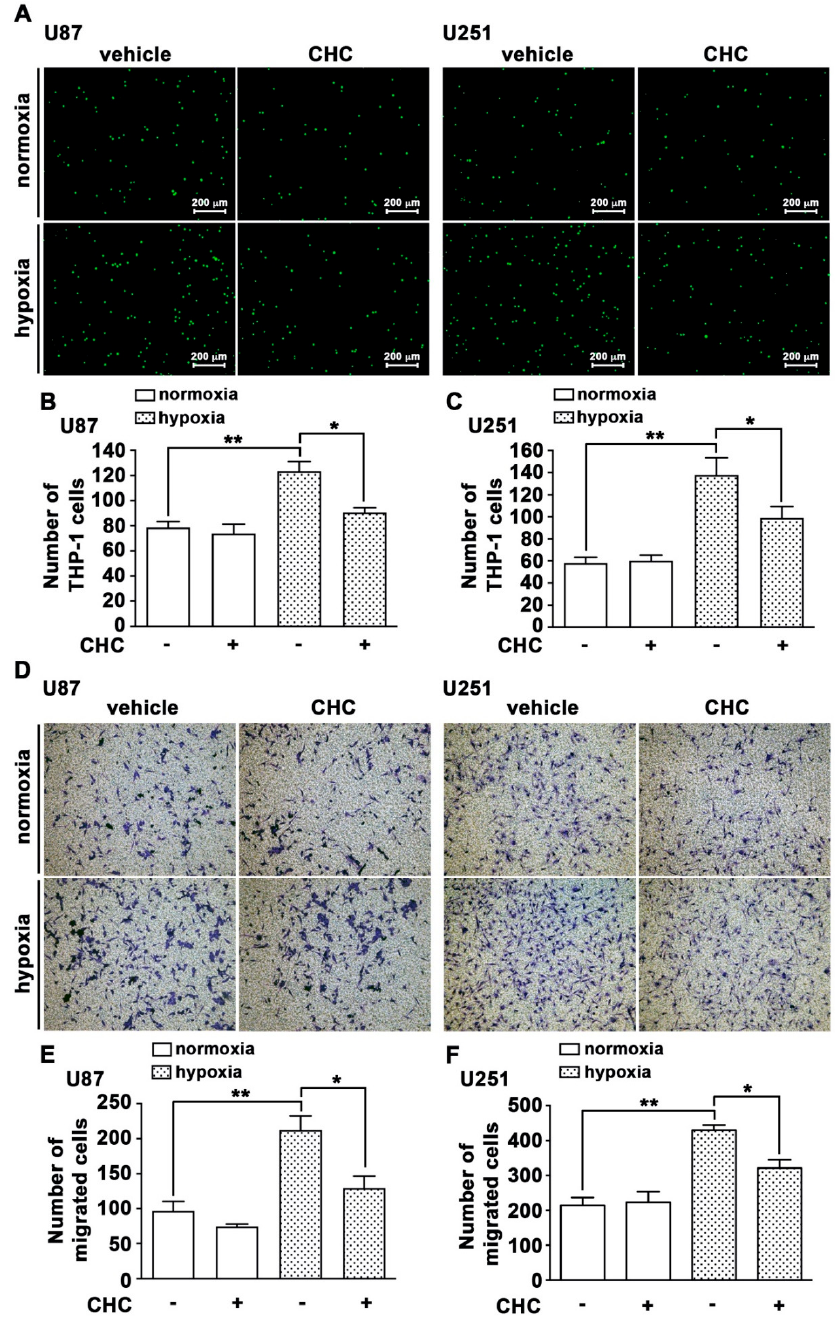
Figure 2. MCT4 is involved in hypoxia-enhanced monocyte adhesion and GBM migration. ( A ) U87 and U251 were treated with an MCT4 inhibitor (CHC; 1 or 2.5 mM) for 30 min and were exposed to hypoxic conditions (1% O 2 ) for 24 h. BCECF-AM-labeled-THP-1 was added to U87 and U251 for 40 min, and then the adherence of THP-1 was captured by fluorescence microscopy. Quantification of THP-1 monocyte adhesion abilities on GBM U87 ( B ) or U251 ( C ). ( D ) GBM U87 and U251 were treated with an MCT4 inhibitor (CHC; 1 or 2.5 mM) for 30 min and were exposed to hypoxic conditions (1% O 2 ), and the migration activities were measured after 24 h by a transwell assay and were visualized using a digital camera. Quantification of GBM U87 ( E ) and U251 ( F ) migration by number of cells that migrated to the underside of the membrane. Two-way ANOVA with a post-hoc Bonferroni test was used to examine the significance of the mean. * p < 0.05 compared with the hypoxia-only group. ** p < 0.01 compared with normoxia control